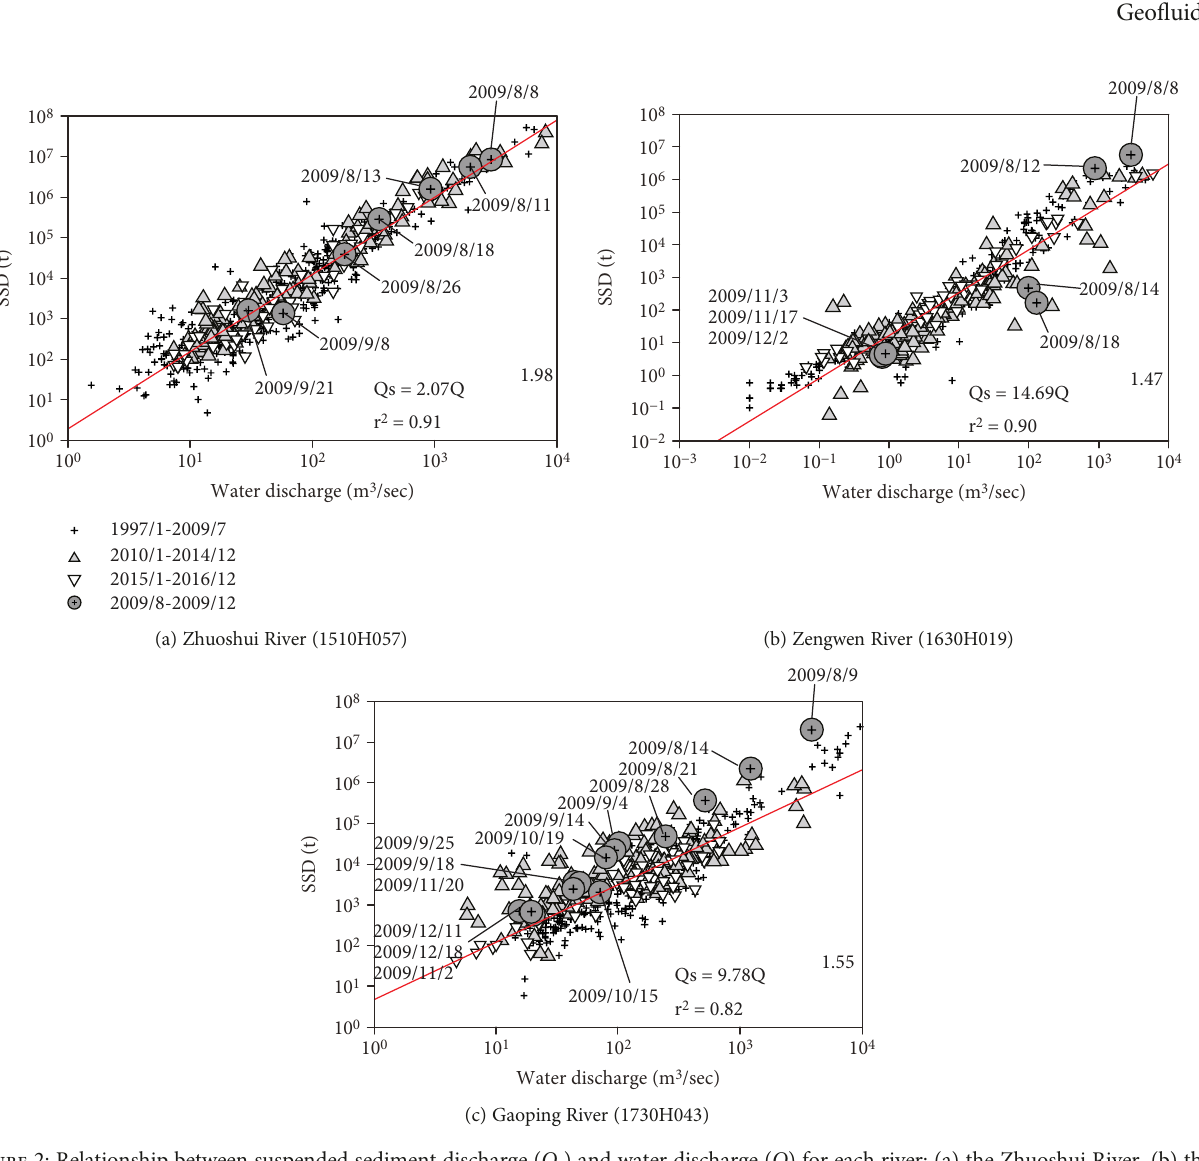
) and water discharge ( Q ) for each river: (a) the Zhuoshui River, (b) the s